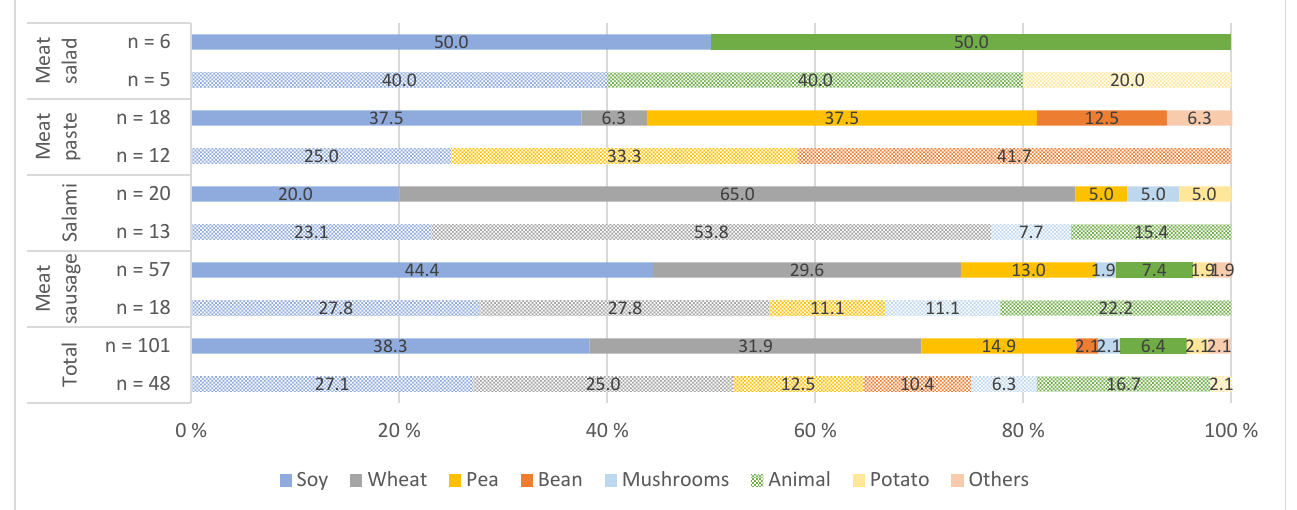
Figure 1. Protein sources used in plant-based meat alternatives (PBMA-hot) in 2019 (patterned color) and 2021 (solid color) (%); n = number of products; animal = milk or/and egg protein; others = beans, sunflower and pumpkin seeds.